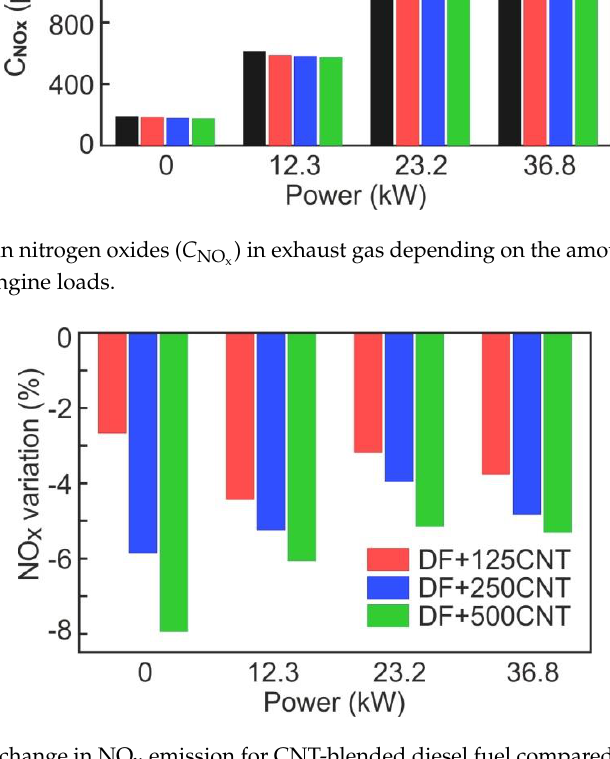
Figure 13. Relative change in NO x emission for CNT-blended diesel fuel compared with NO x emission for pure petroleum diesel fuel (the NO x content in exhaust gas for diesel engine fueled with pure petroleum DF was taken as the basic NO x emission value).